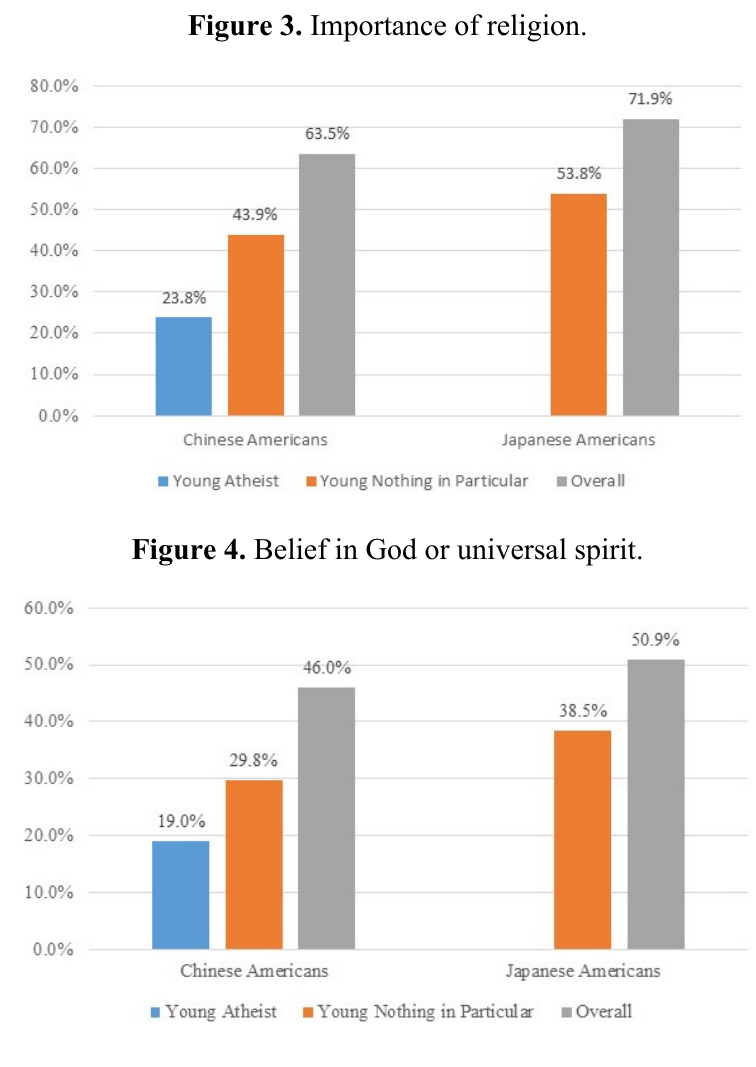
Figure 5. Belief in